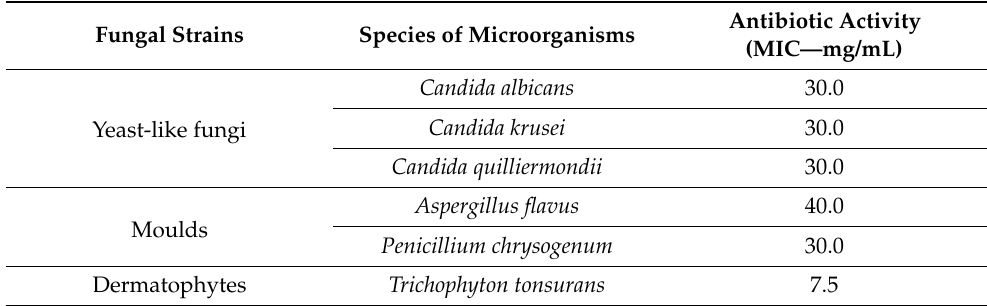
Table 6. Antifungal activity (MIC—minimum inhibitory concentration) of the methanol extract ob- tained from biomass of in vitro shoot culture of Scutellaria brevibracteata subsp. subvelutina (3.0 mg/L BAP and 1.0 mg/L